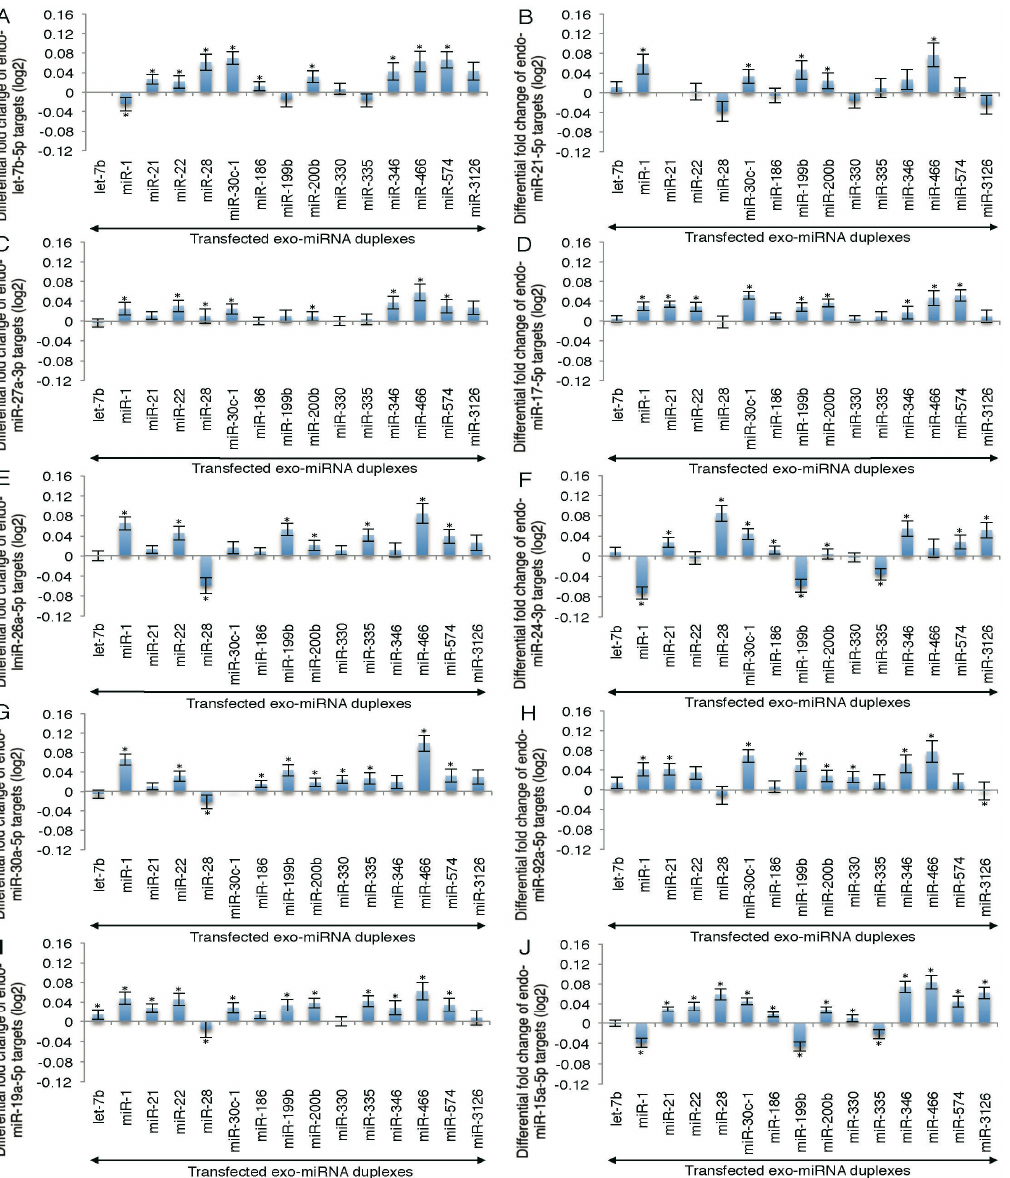
Figure 2. Mean fold changes of the expression levels of endo-miRNA target transcripts by the transfection of different exo-miRNAs. HeLa cells were transfected with each of fifteen exo-miRNA duplexes, log mean differential fold changes of the expression levels of 2 seed-matched target genes of each of the top 20 endo-miRNAs were calculated. Data were shown with respect to endo-miRNAs, let-7b-5p ( A ); miR-21 ( B ); mR-27a-3p ( C ); miR-17-5p ( D ); miR-26a-5p ( E ); miR-24-3p ( F ); miR-30a-5p ( G ); miR-92a-5p ( H ); miR-19a-5p ( I ); miR-15a-5p ( J ); miR-22-3p ( K ); miR-29a-3p ( L ); miR-125a-5p ( M ); miR-93-5p ( N ); miR-191-5p ( O ); miR-103a-3p ( P ); miR-143-3p ( Q ); miR-100-5p ( R ); miR-23a-3p ( S ); and mR-186-5p ( T ); and their averaged values were shown in ( U ). Note that each exo-miRNA increased the endo-miRNA target genes in different degrees. The individual data are shown in Figures S2–S21. Data represent the mean ± SE ( * p <